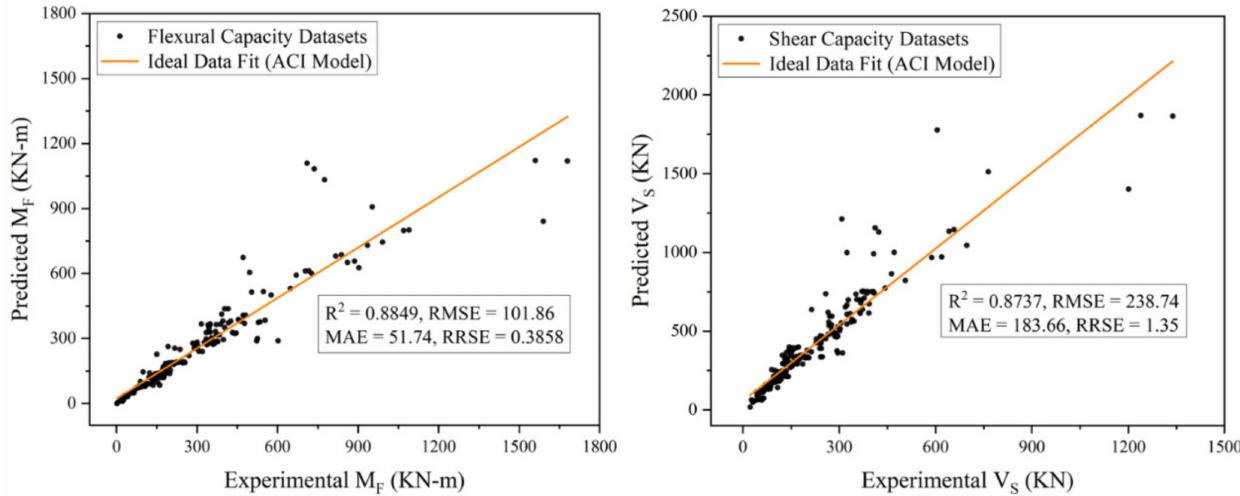
Figure 9. Predicted Versus Experimental Values Plot for ACI